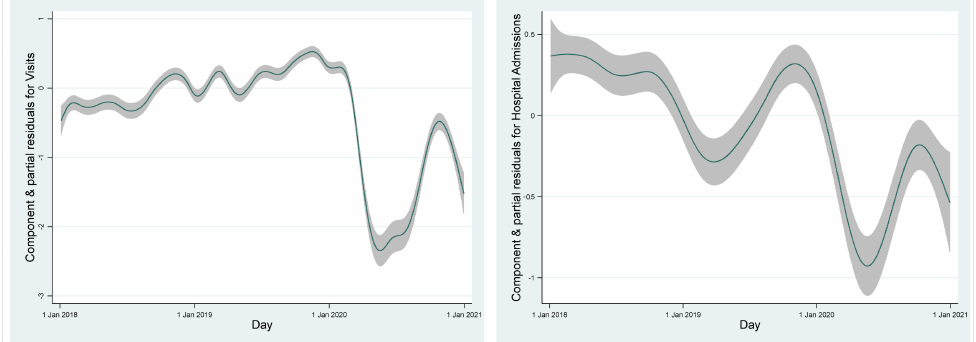
Figure 1. Smoothed time course of daily ambulatory visits ( left ) and stationary hospital admissions ( right